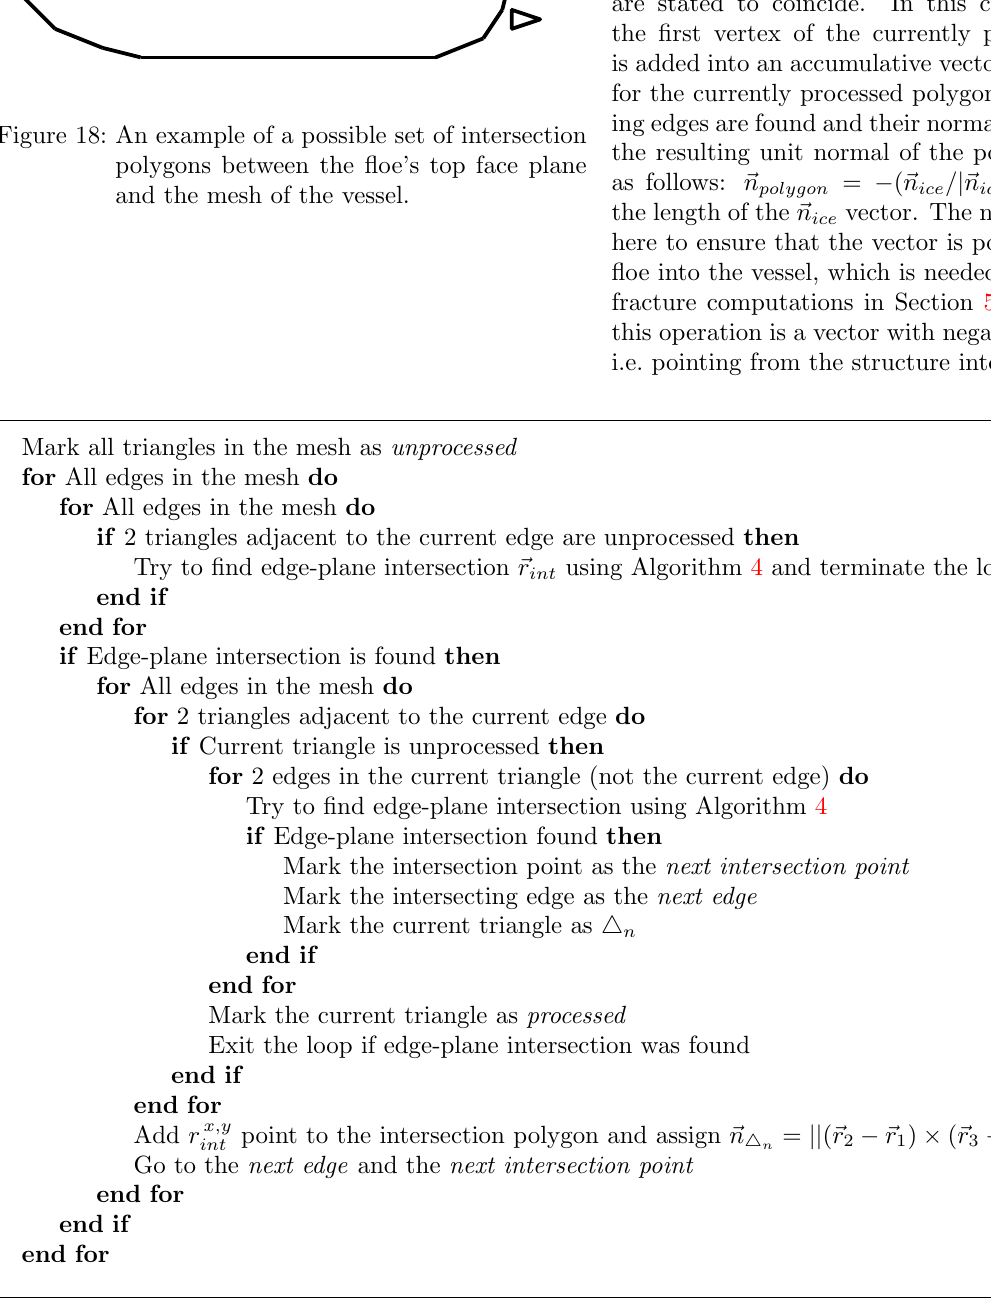
Figure 17: Mesh-plane intersection computation